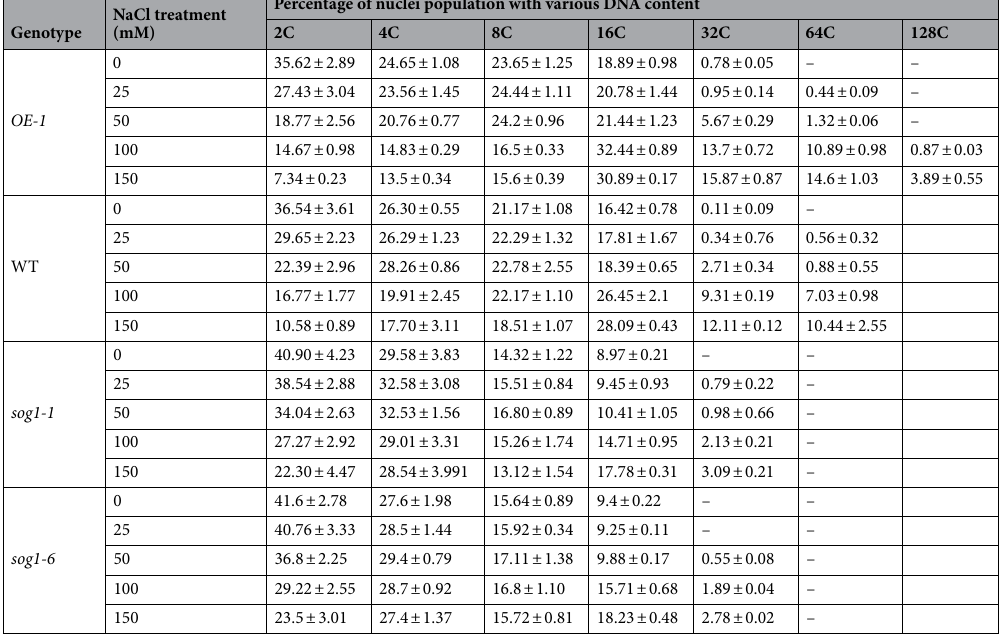
Table 1. Percentage of nuclei populations with various DNA content in four genotypes following exposure to increasing concentrations of